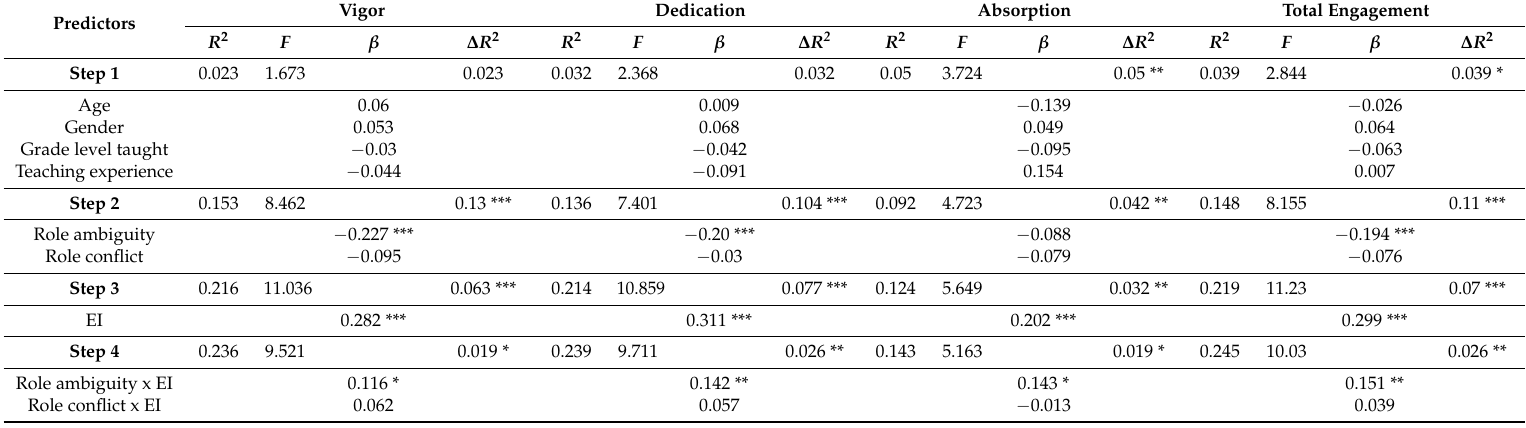
Table 2. Hierarchical regression analysis showing the amount of variance in engagement accounted for by role stressors and emotional intelligence (EI) interactions. Vigor Dedication Absorption Total Engagement Predictors